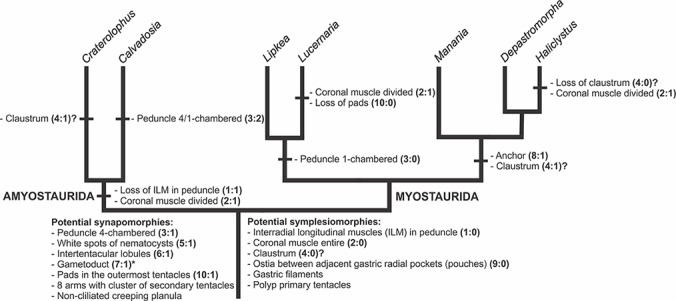
Hypothesis of character evolution for staurozoan genera included in the recent molecular phylogenetic hypothesis (Miranda et al., 2016).ACCTRAN optimization of morphological and life-history features (modified from Miranda et al., 2016). Characters 1–10 examined in this study (see Table 3 for detailed information). “?” Equivocal character (see Table 3). If claustrum is considered a symplesiomorphy of Staurozoa, it was lost in Calvadosia, Haliclystus, and in the clade Lucernaria + Lipkea (most parsimonious reconstruction). *Presence of gametoducts in other cnidarians requires further studies.